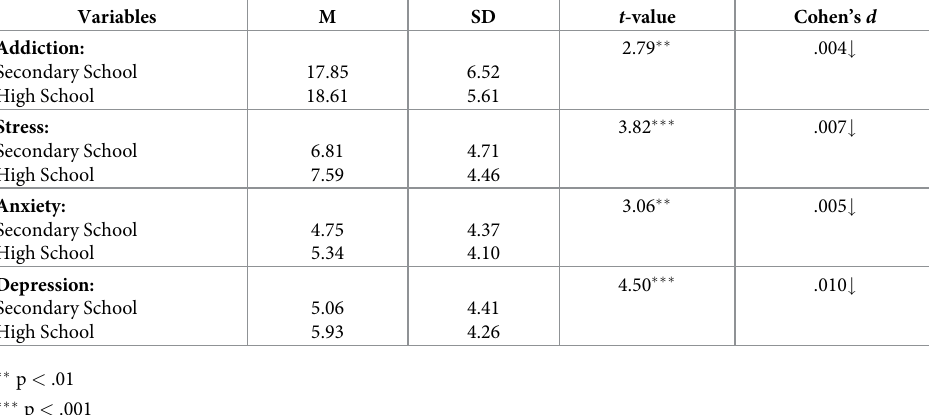
Table 6. T -tests comparing secondary school students (n = 974) and high school students (n = 1,019) in the study variables (df =